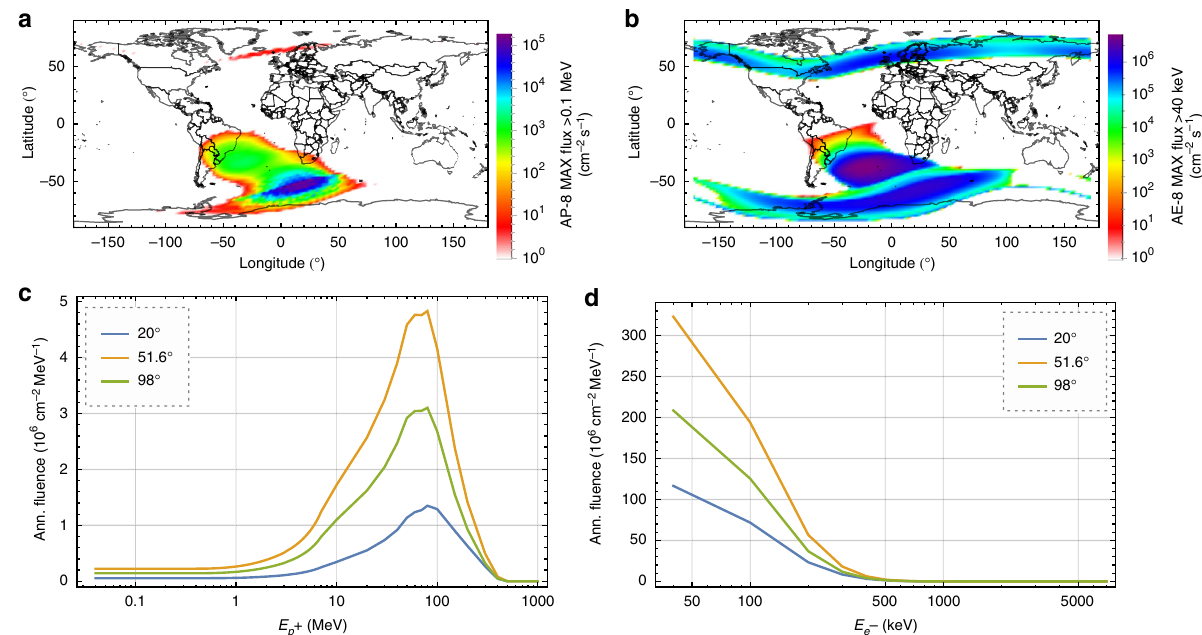
Fig. 1 Space environment. Geographical distribution of the trapped a proton and b electron fl ux at 500 km altitude, calculated with the AP-8 MAX and AE-8 MAX models in SPENVIS, respectively. Integrated annual c proton and d electron fl uence after 1.85 mm of Al shielding for typical orbital